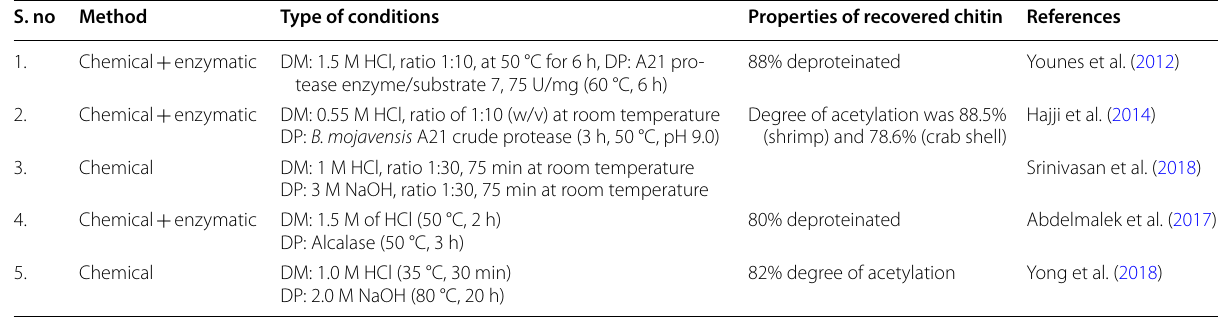
Table 1 Chemical extraction methods for recovery of